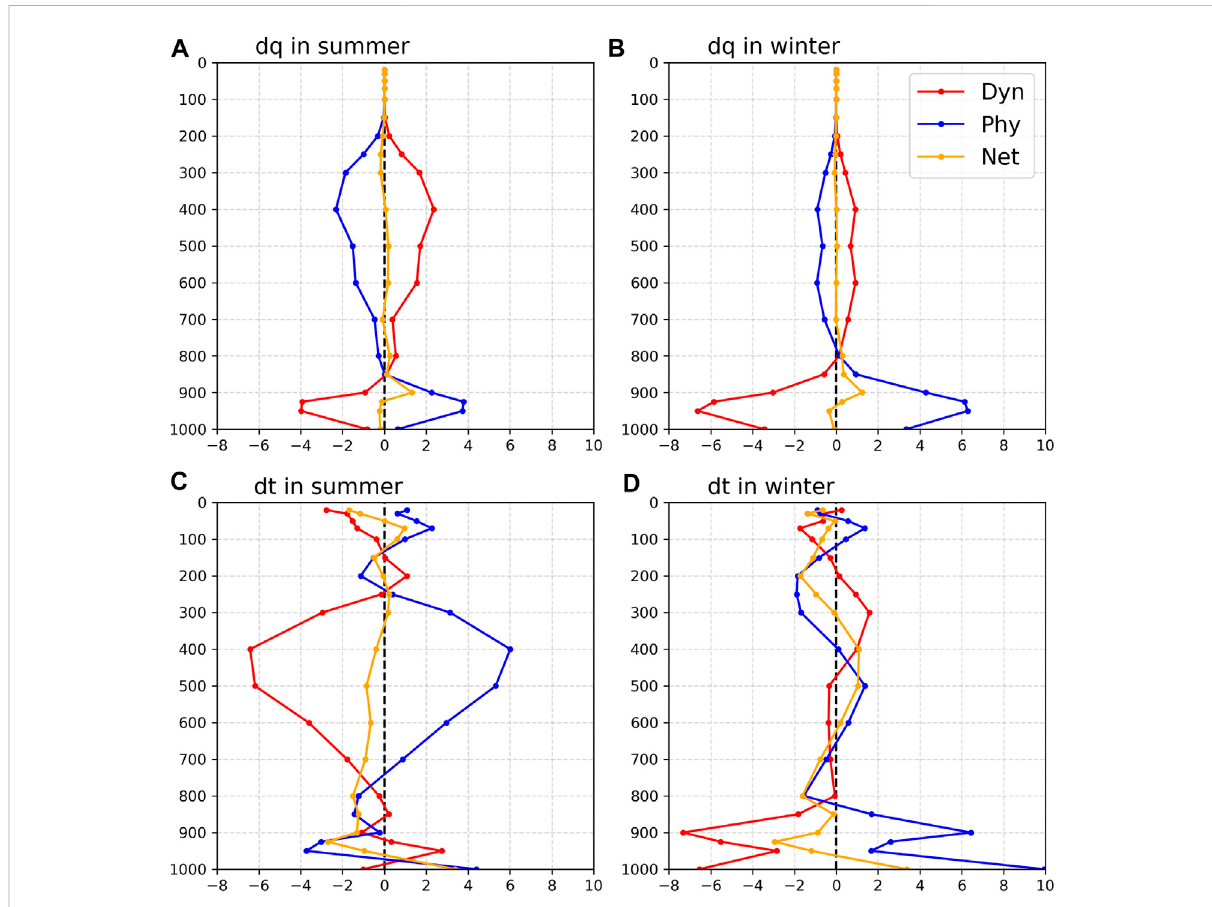
FIGURE 3 Regional average vapour and temperature tendencies. (A) Summer vapour tendency. (B) Winter vapour tendency. (C) Summer temperature tendency ( ° C). (D) Winter temperature tendency; dynamic process tendency (red line), physical process tendency (blue line), and net tendency